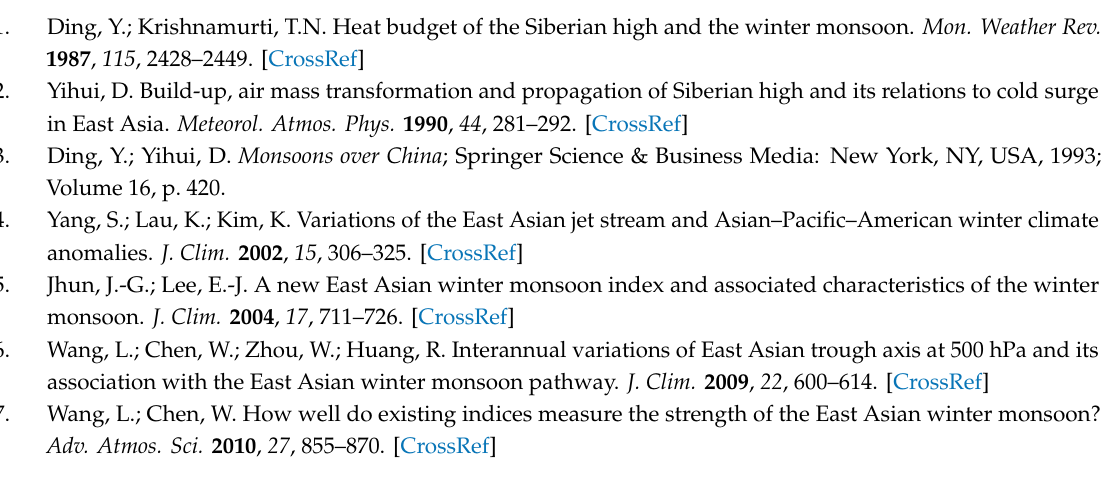
Figure S1: Composite maps of SST anomalies in winter season for in in-phase groups; Figure S2: SST anomalies in individual case of the out-of-phase groups; Figure S3: Composite maps of SST, U300 and Z300 anomalies in GFDL-CM3 historical simulation.; Figure S4: Same as Figure S4 but for